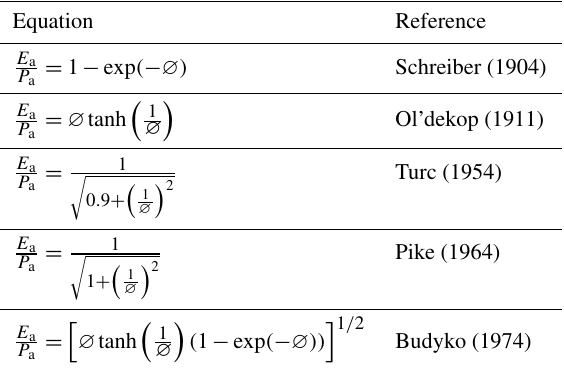
Table 1. Budyko equations developed by different researchers.